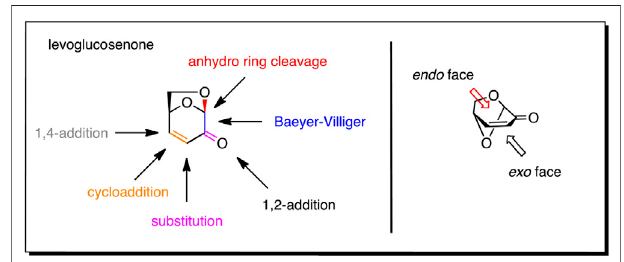
FIGURE 1 | Reactions useful for derivitizing levoglucosenone.